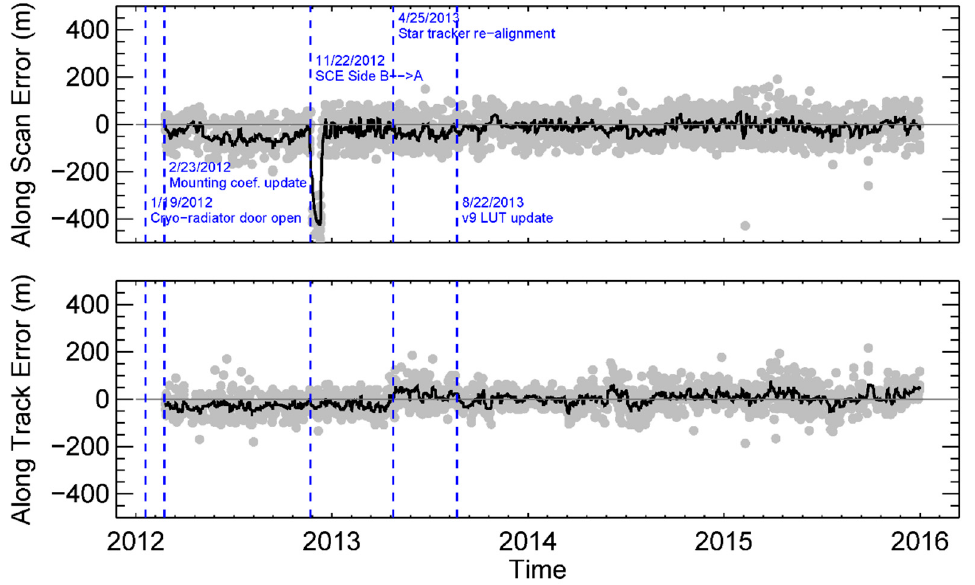
Figure 6. I-bands geolocation errors in the along scan ( top ) and along track direction ( bottom ) for the NOAA operational I-bands terrain-corrected geolocation product.